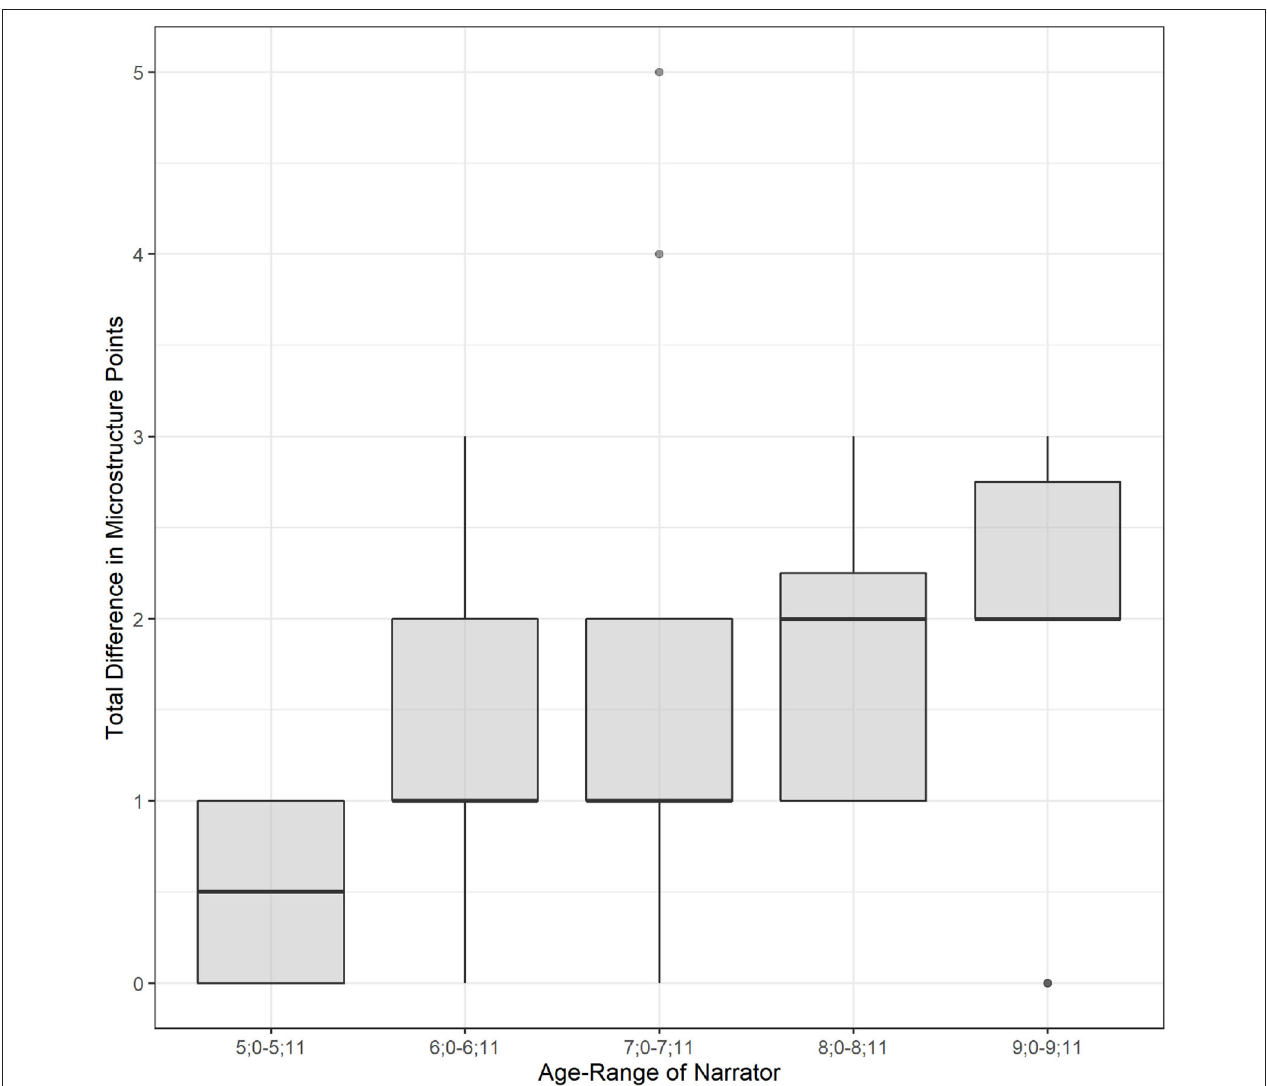
FIGURE 1 | Absolute difference in total Microstructure score (Expert to LLUNA) across age-ranges